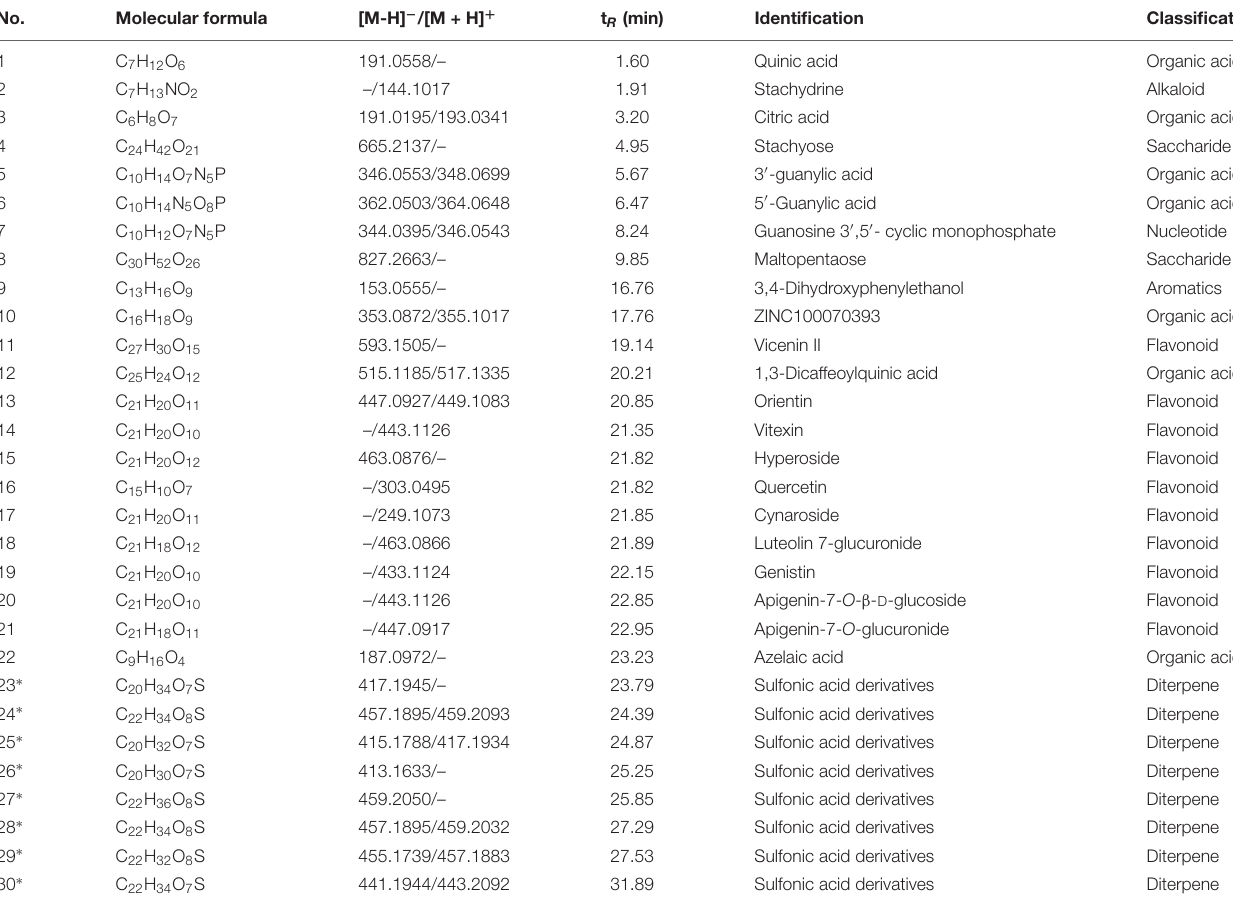
TABLE 2 | Information of 30 components of Herba Siegesbeckiae (HS) aqueous extract determined by LC-MS (*, unreported compound in HS). No. Molecular